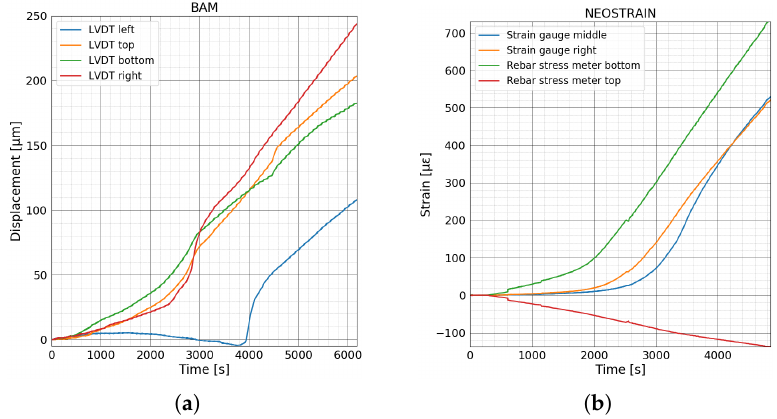
Figure 12. ( a ) Displacements measured by LVDT sensors at BAM. ( b ) Strain variation inside concrete and rebars measured by strain gauges and rebar stress meters at NEOSTRAIN.